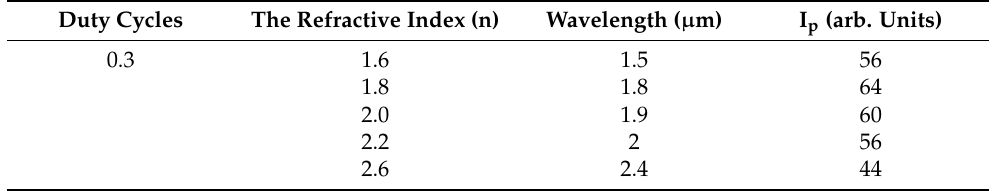
Figure 4. Light intensity distribution of 9-layer superlens under different conditions: ( a ) duty cycle is 0.3, refractive index is 1.8 and wavelength is 1.8; ( b ) duty cycle is 0.35, refractive index is 2.6 and wavelength is 2.6; ( c ) duty cycle is 0.4, refractive index is 1.6 and wavelength is 1.8; ( d ) duty cycle is 0.45, refractive index is 2.6 and wavelength is 2.5. Table 2. Effective convergence-point parameters corresponding to different duty cycles and refractive